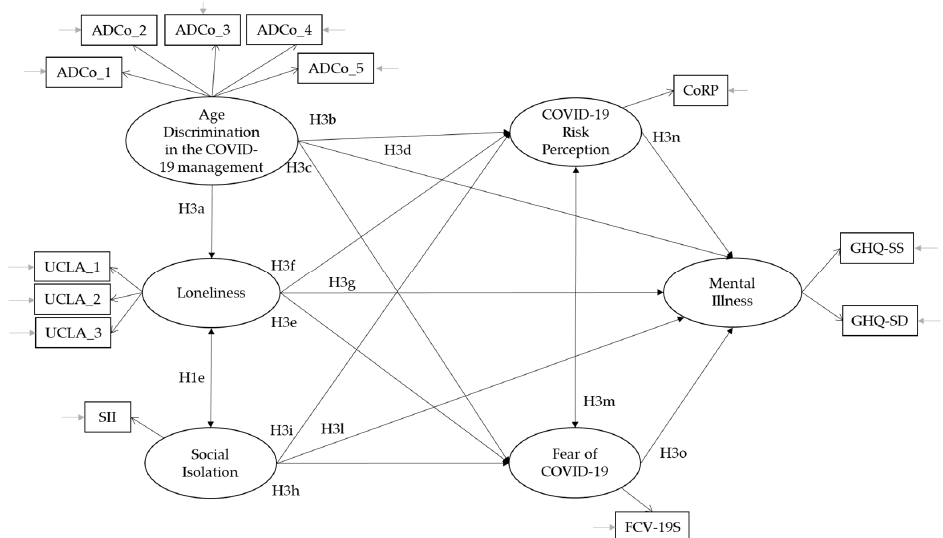
Figure 1. Conceptual Model .